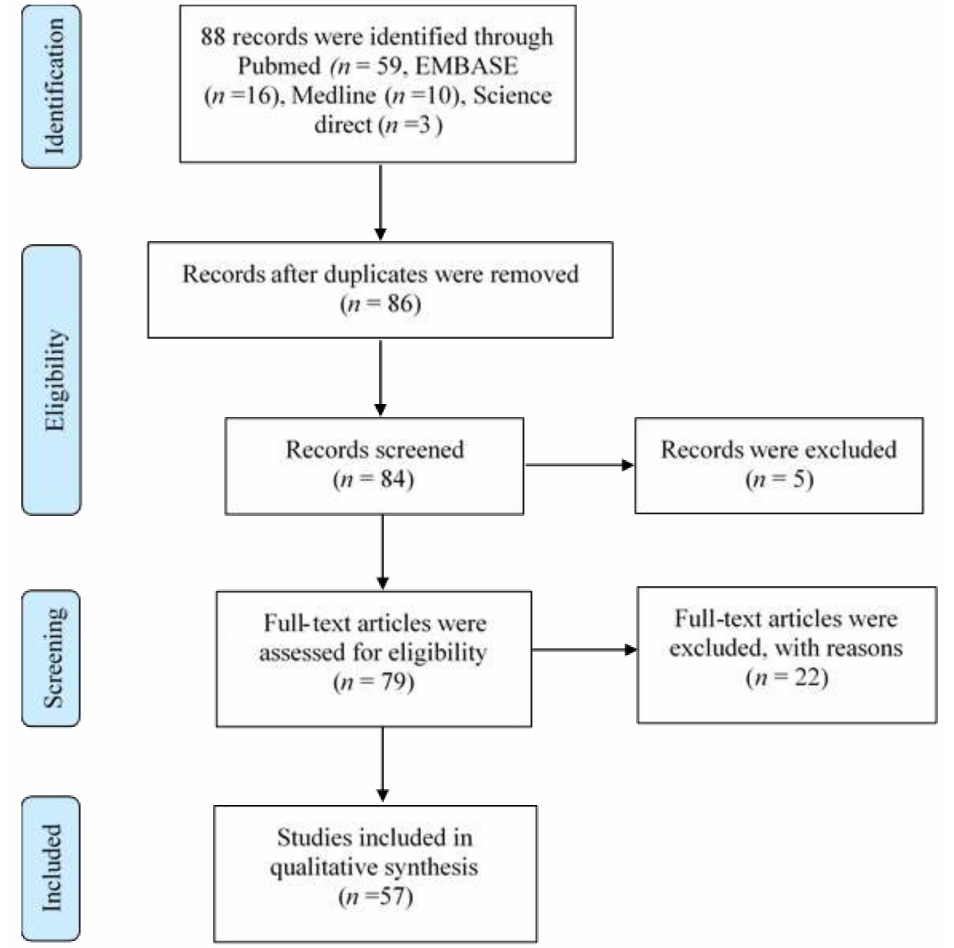
Figure 1. Flow diagram of identification, screening, eligibility, and included